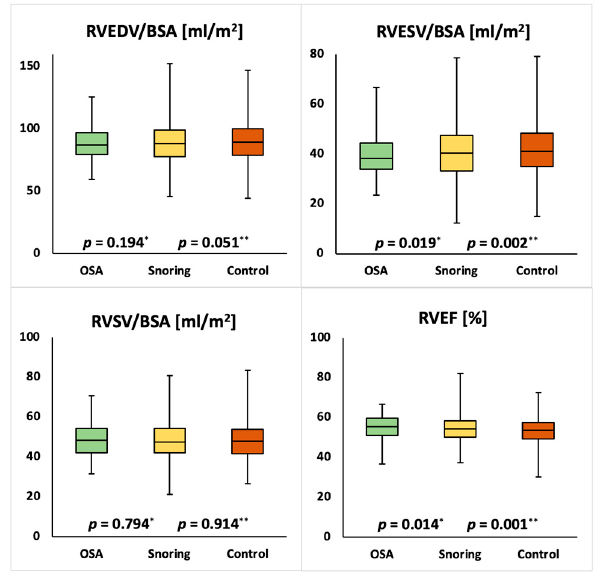
Figure 5. Comparison of right ventricular ejection fraction (RVEF) and end-diastolic volume index (RVEDVI), end-systolic volume index (RVESVI) and stroke volume index (RVSVI) in male individuals with obstructive sleep apnea (OSA), snoring or none of the above. p -values for OSA vs. unaffected (*) and snoring vs. unaffected (**) are reported.